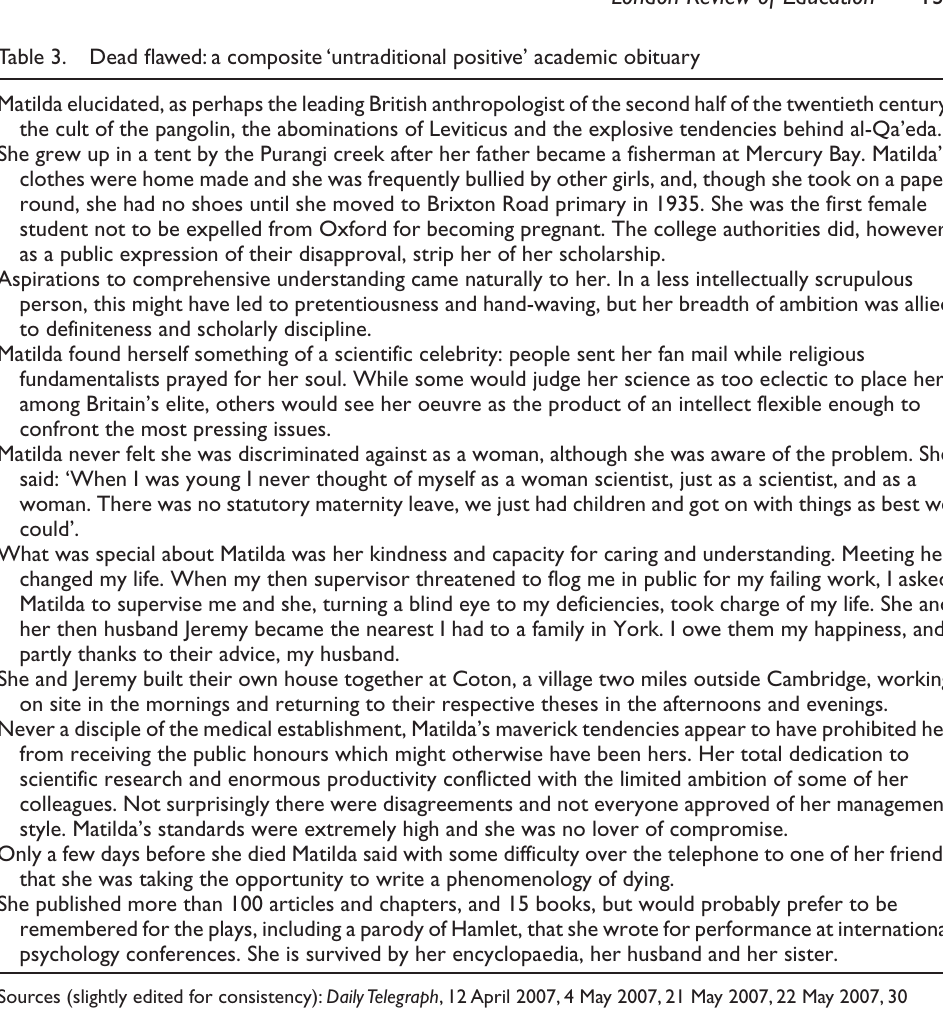
Table 3. Dead flawed: a composite ‘untraditional positive’ academic obituary Matilda elucidated, as perhaps the leading British anthropologist of the second half of the twentieth century, the cult of the pangolin, the abominations of Leviticus and the explosive tendencies behind al-Qa’eda. She grew up in a tent by the Purangi creek after her father became a fisherman at Mercury Bay. Matilda’s clothes were home made and she was frequently bullied by other girls, and, though she took on a paper round, she had no shoes until she moved to Brixton Road primary in 1935. She was the first female student not to be expelled from Oxford for becoming pregnant. The college authorities did, however, as a public expression of their disapproval, strip her of her scholarship. Aspirations to comprehensive understanding came naturally to her. In a less intellectually scrupulous person, this might have led to pretentiousness and hand-waving, but her breadth of ambition was allied to definiteness and scholarly discipline. Matilda found herself something of a scientific celebrity: people sent her fan mail while religious fundamentalists prayed for her soul. While some would judge her science as too eclectic to place her among Britain’s elite, others would see her oeuvre as the product of an intellect flexible enough to confront the most pressing